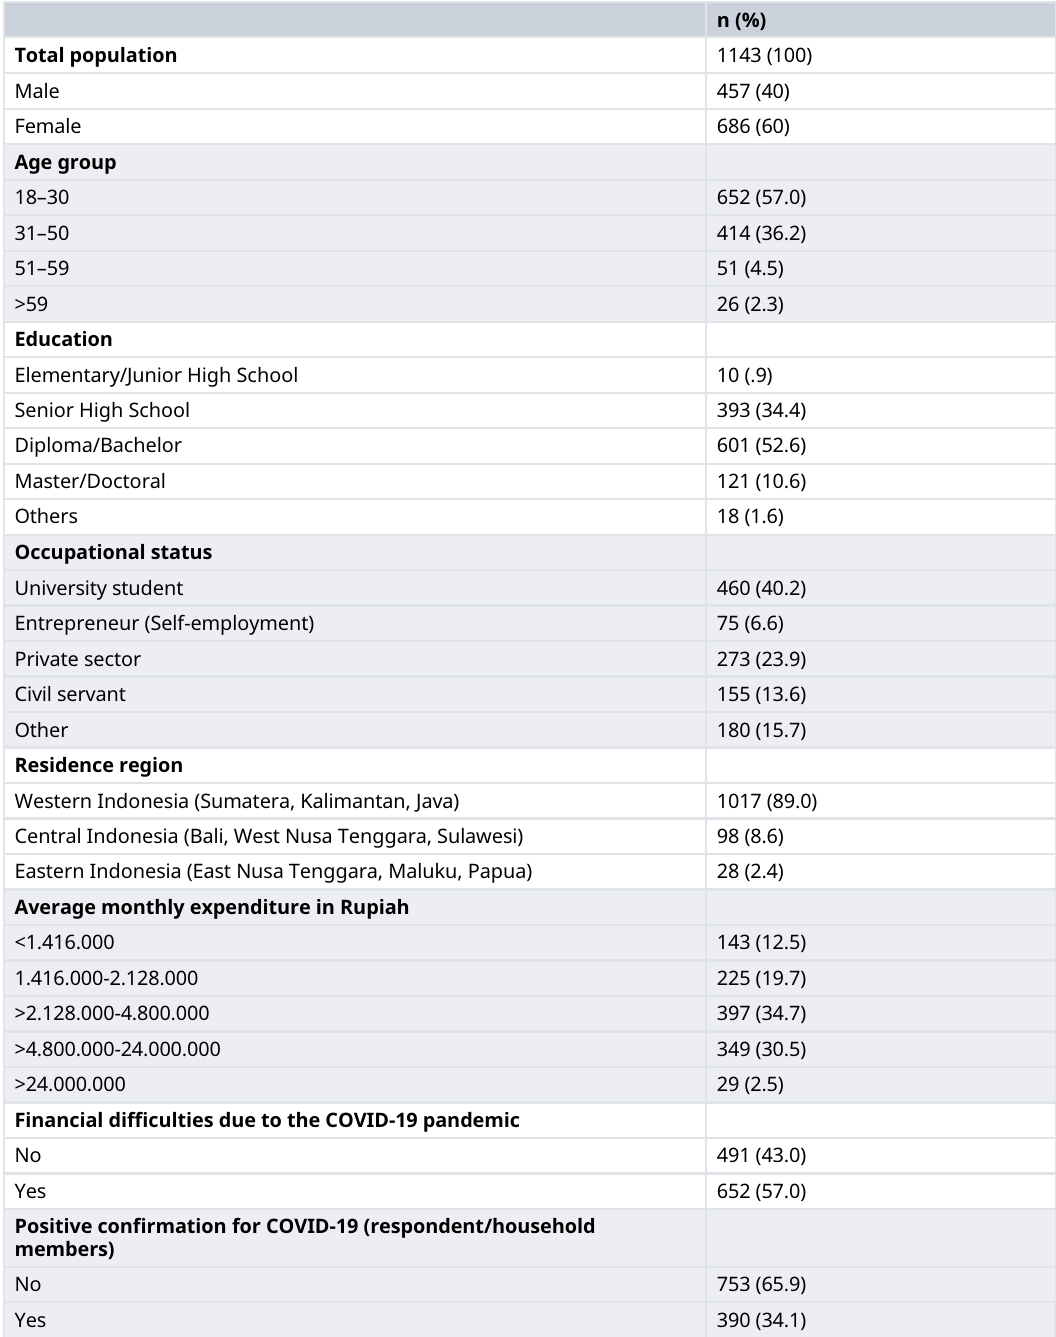
Table 2. Demographic characteristics of the